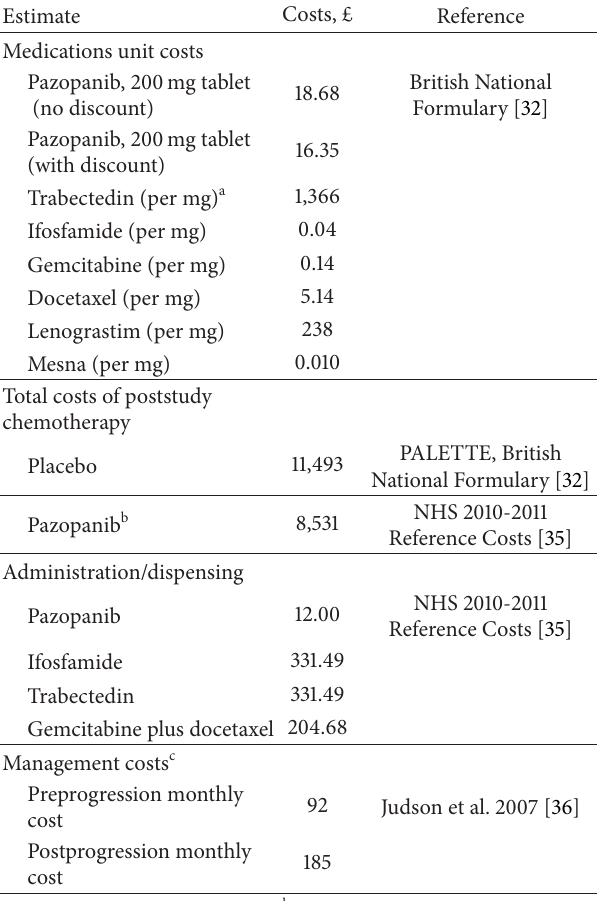
Table 4: Cost estimates used in the